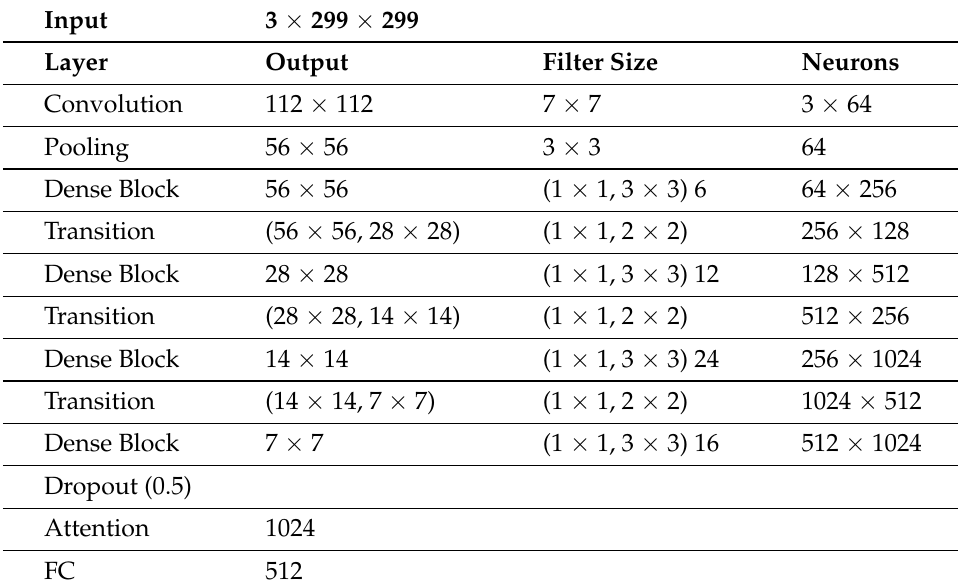
Table 1. Bilinear attention network’s parameter information (densenet121)